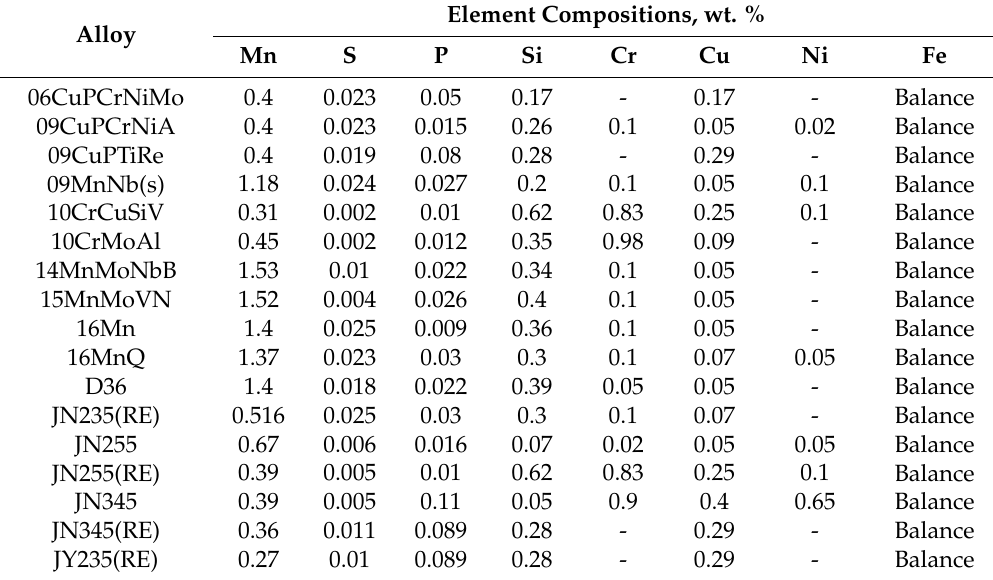
Table 1. Element compositions of 17 low alloy steels (LAS) in the collected datasets.